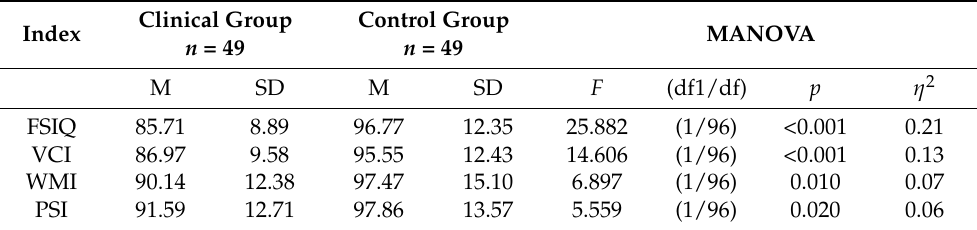
Table 3. Mean and standard deviation and MANOVA results for FSIQ, VCI, WMI and PSI by group.